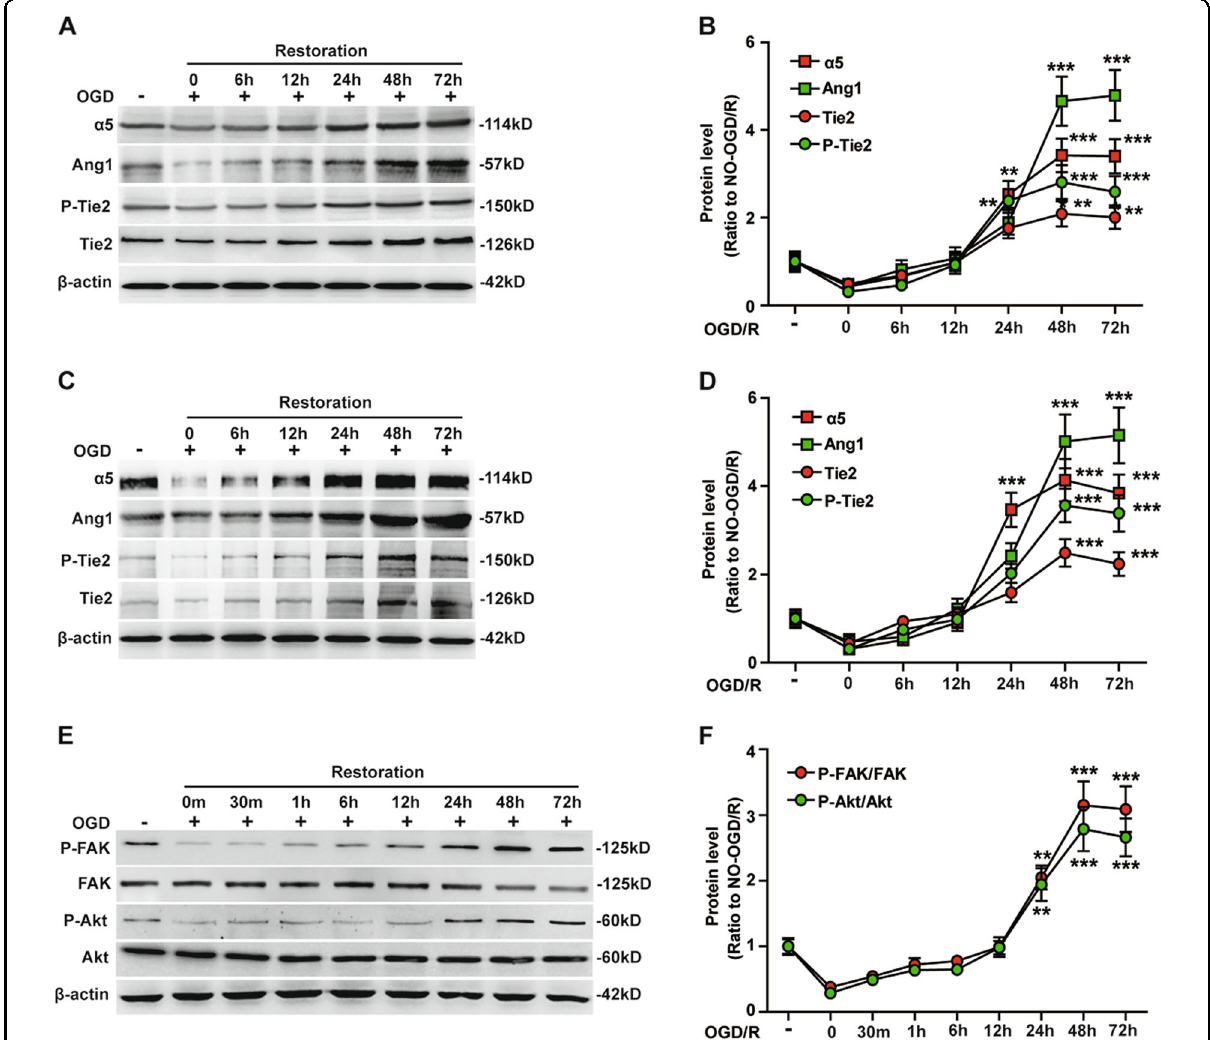
Fig. 1 OGD/R induces the upregulation of Tie2 expression and activation of the downstream signaling molecules FAK and Akt in BECs. BECs (bEnd3 cells and HBMECs) were subjected to 4 h of oxygen – glucose deprivation (OGD) followed by 72 h of restoration (R) at 37 °C. Cell lysates at each time point were analyzed by western blotting using antibodies speci fi c for integrin α 5, Ang1, and total protein or phosphorylated form of Tie2, focal adhesion kinase (FAK) and Akt. a Representative western blots of integrin α 5, Ang1 and total and phosphorylated form of Tie2 in bEnd3 cells are shown. b Protein levels for A were quanti fi ed by densitometry and are presented as ratios to β -actin. c Representative western blots of integrin α 5, Ang1 and total and phosphorylated form of Tie2 in HBMECs are shown. d Protein levels for C were quanti fi ed by densitometry and are presented as ratios to β -actin. e Representative western blots of phosphorylated FAK, phosphorylated Akt, total FAK and total Akt are shown. f Protein levels were quanti fi ed by densitometry and normalized to total FAK/Akt. The NO-OGD/R cells served as a control. Note that the levels of phosphorylated and total Tie2 decreased immediately after OGD insult but then began to increase and continued to increase with time of restoration, reaching a maximum at 48-72 h after restoration, similar to the expression of α 5 integrin and Ang1. In the fi rst 12 h following ischemic insult, OGD/R reduced phosphorylation of both FAK and Akt, but by the 24 – 72 h time point, the levels of both phosphorylated FAK and Akt were signi fi cantly